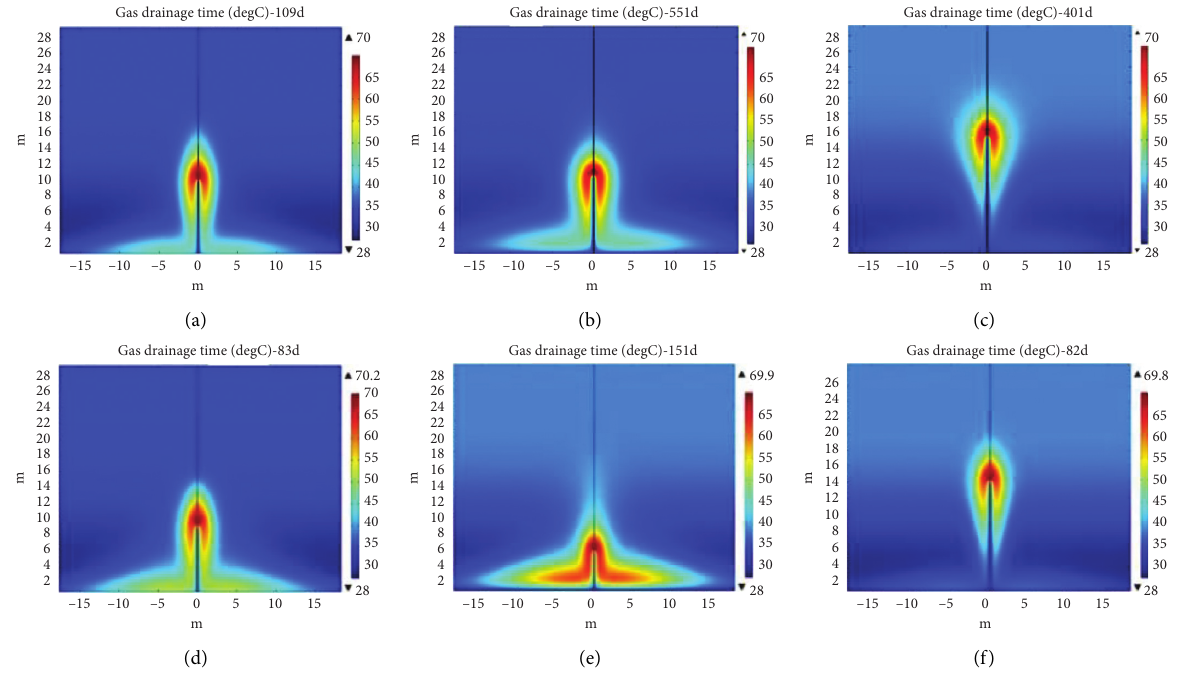
Figure 4: Simulation results under different scenarios. (a) 2. (b) 4. (c) 6. (d) 8. (e) 10. (f)